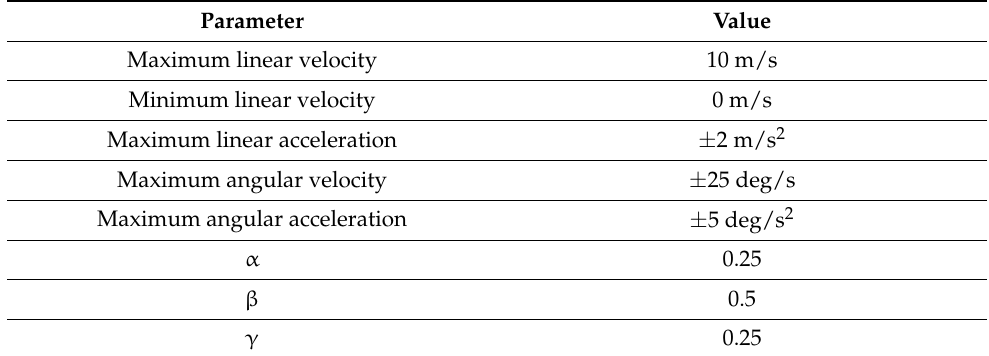
Table 1. Parameters for DWA and CCDWA. Parameter Value Maximum linear